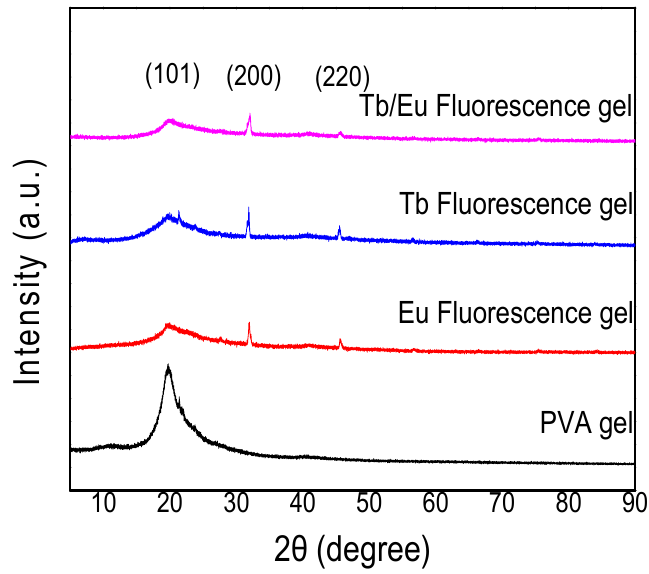
Figure 3. X-ray-di ff raction (XRD) curves for PVA gel and Eu, Tb, and Tb / Eu fluorescence Figure 3. X-ray-diffraction (XRD) curves for PVA gel and Eu, Tb, and Tb/Eu fluorescence gels.